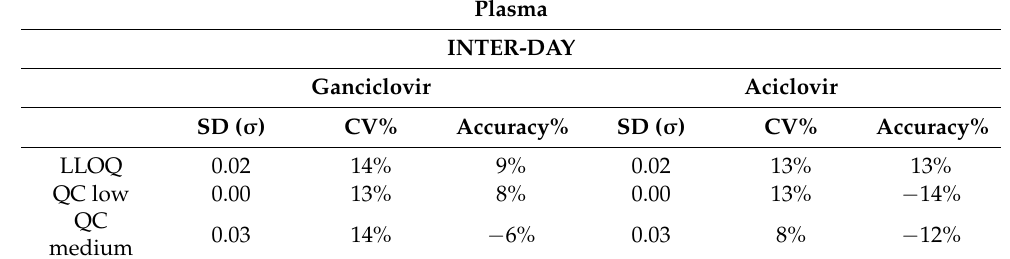
Table 1. Results of intra-day and inter-day accuracy and reproducibility assays for plasma and DPS ( n , replicates; ( n ) = 5). The quality control concentrations were, respectively, 0.01, 0.02, 0.5, and 10 mg/L for LLOQ, QClow, QC medium, and QC high. (SD, Standard deviation; CV%, coefficient of variation